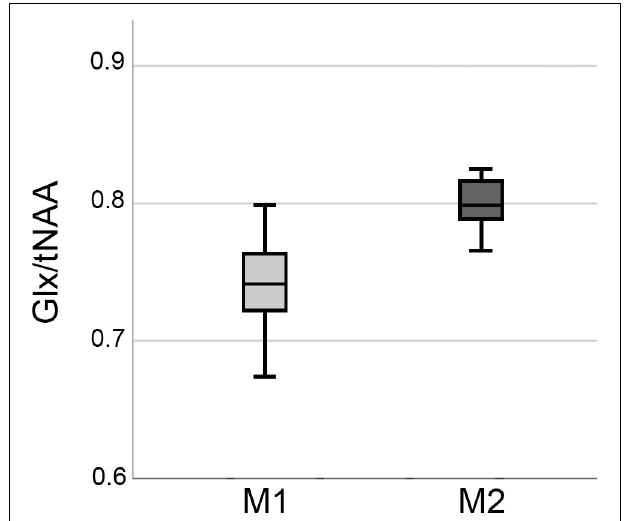
FIGURE 3 | Boxplots showing elevations in Glx/tNAA ratio in the right caudal middle frontal area before (M1) and after the treatment period (M2). Glx, combined measure of glutamate and glutamine; tNAA, total N-acetylaspartate.